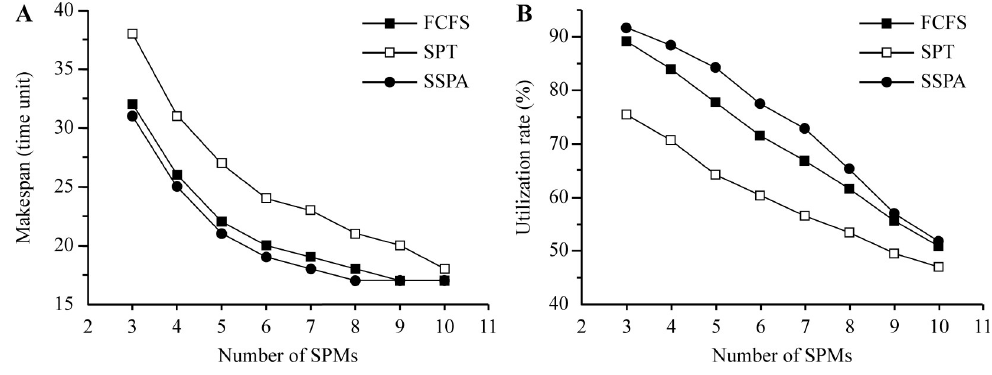
Fig 10. Results for variable number of SPMs. (a) Makespan and (b) utilization rate.